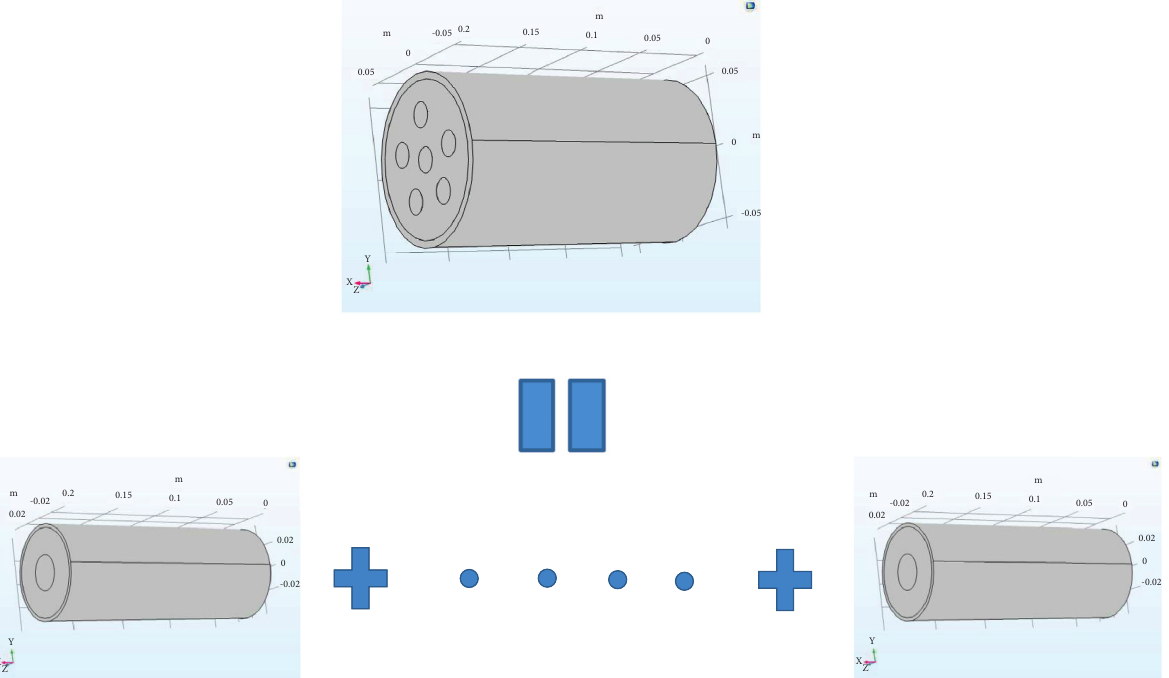
Figure 8: One reactor with a number of heating tubes is divided into the same number of reactors with one heating tube with an equal amount of